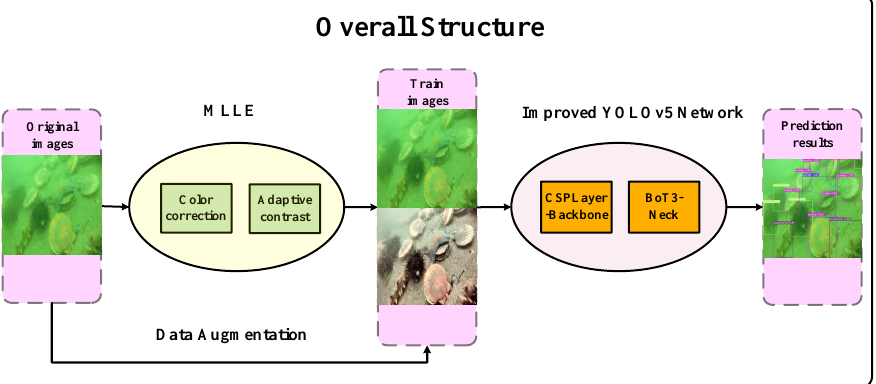
Figure 2. The general object-detection